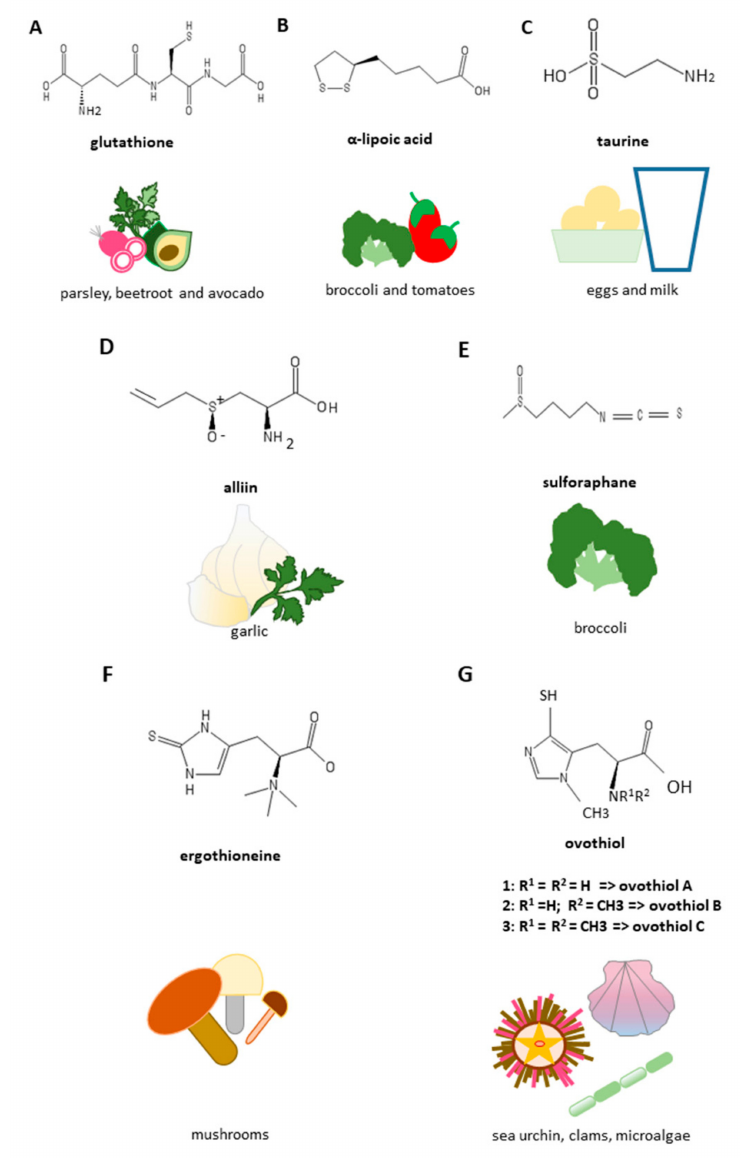
Figure 4. Structures and richest food sources of anti-fibrotic sulfur-containing compounds. ( A ) Glutathione; ( B ) α -lipoic acid; ( C ) taurine; ( D ) alliin; ( E ) sulforaphane; ( F ) ergothioneine; ( G )